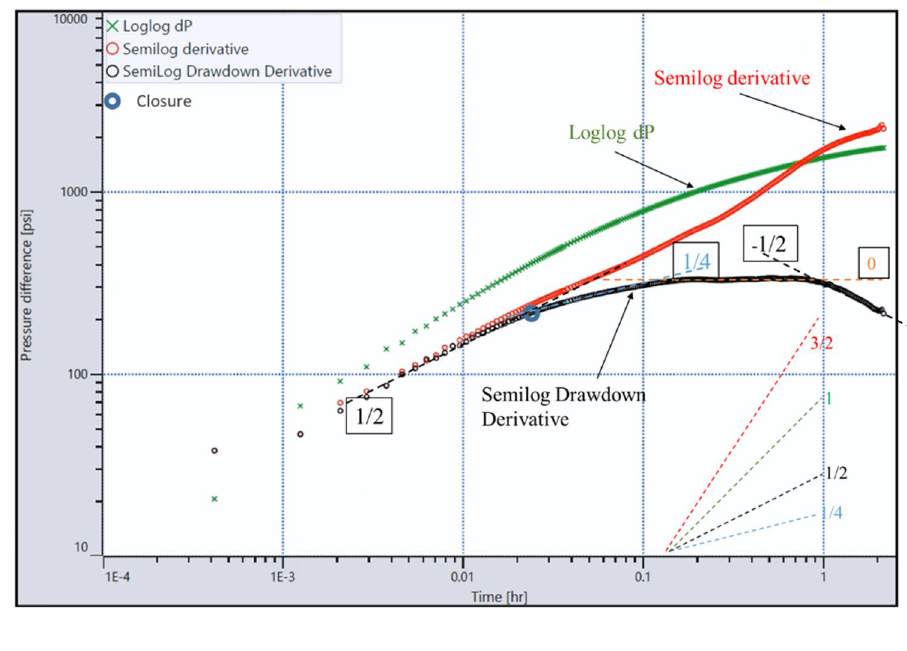
Fig. 12 A G-function plot for the DFIT test (Cycle #5) with multi-closure events. The humps in the G-function plots correspond to three closing events, two of natural fractures and the other of the tensile